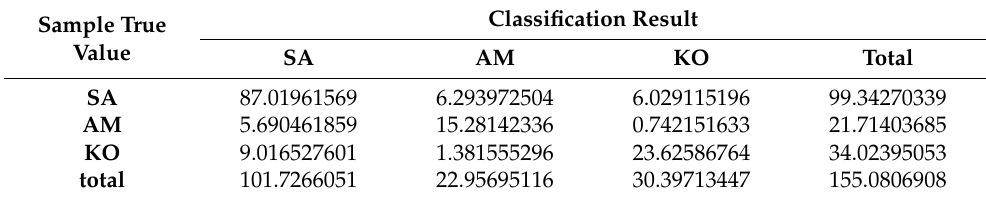
Table 7. Space transition matrix of ERT algorithm (Area unit: ha).